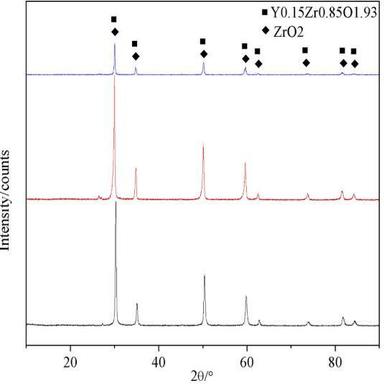
XRD of YSZ for TY-3-2 under different conditions. (a)after ablation, (b) before ablation, (c)raw powder.